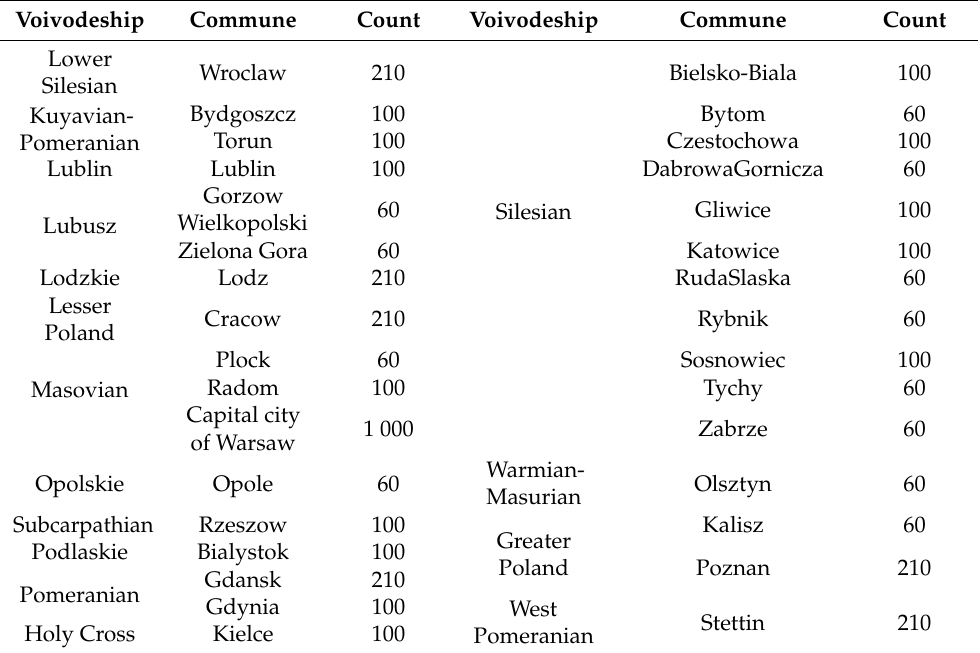
Table 3. Minimum number of public charging points according to the Act of January 11, 2018 on Electromobility and Alternative